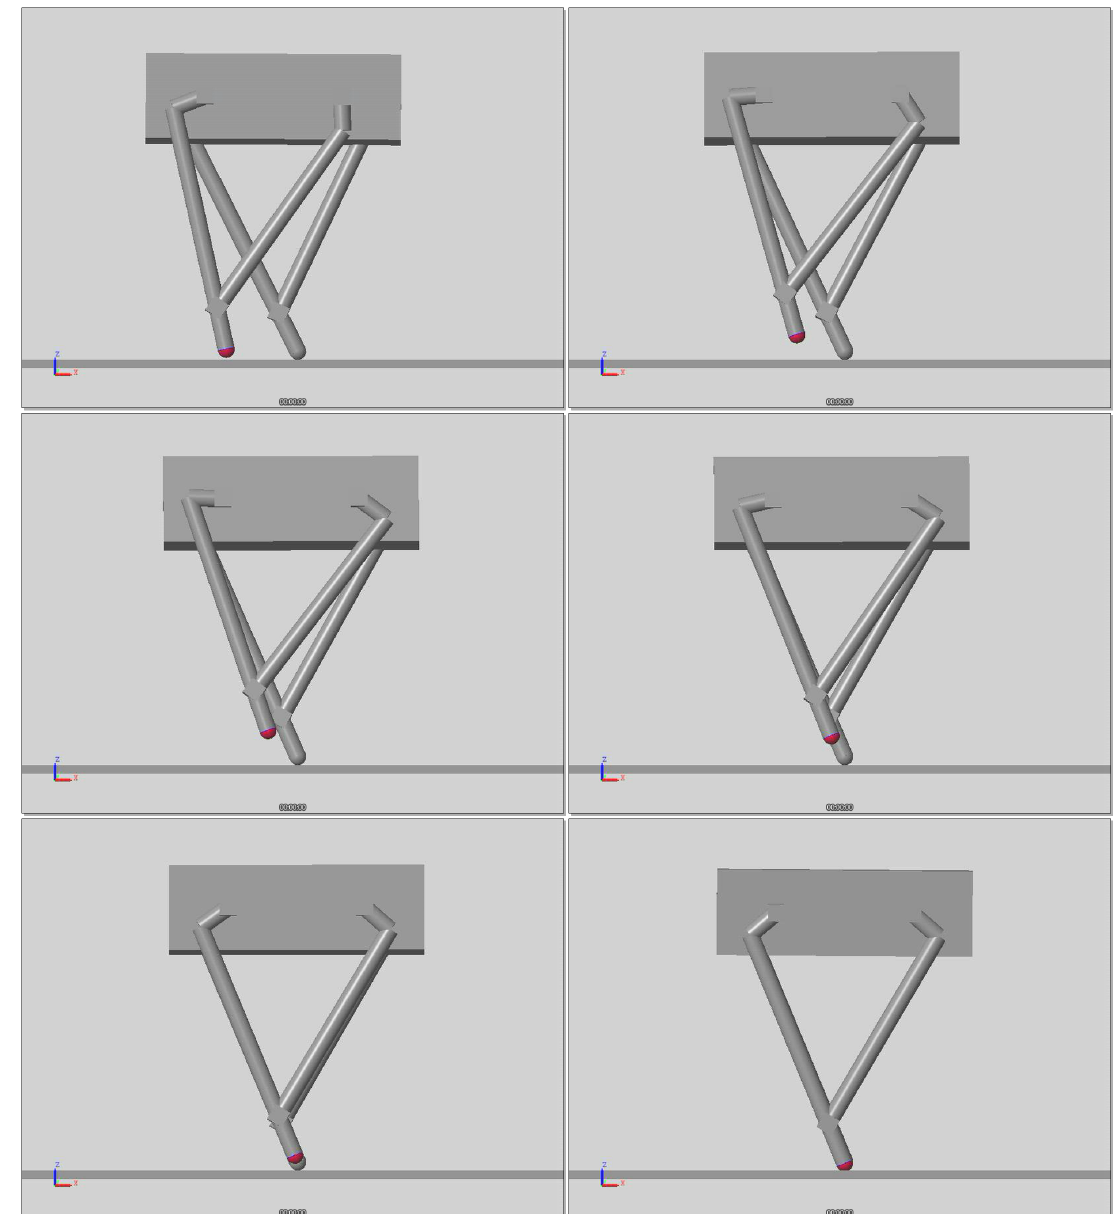
Figure 14. Still shot of one step